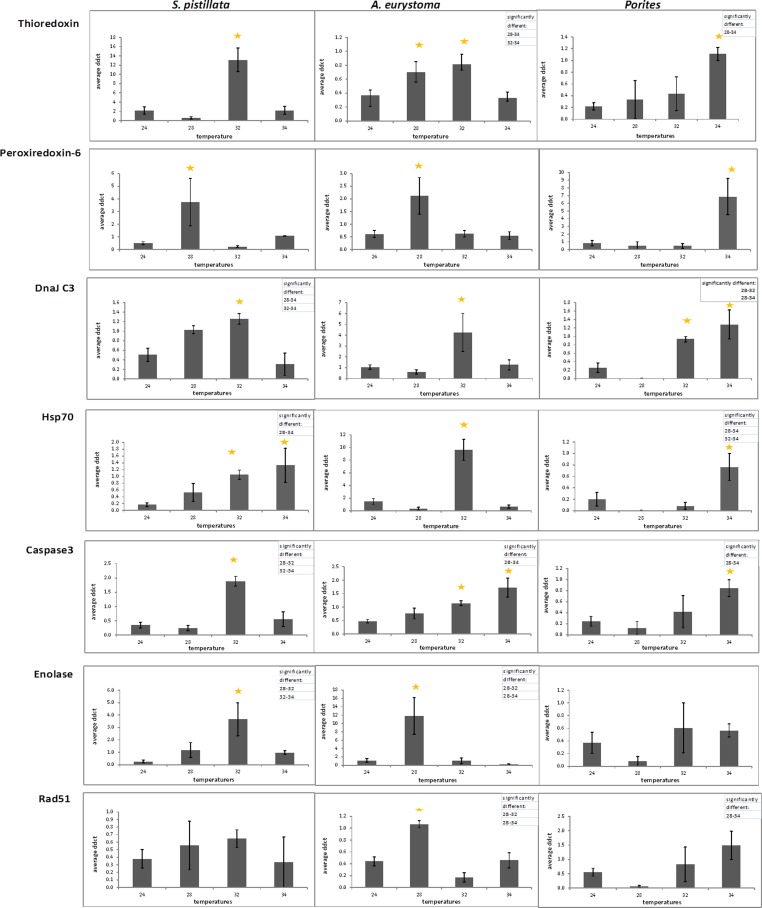
Gene expression following treatment of 28 °C, 32 °C, 34 °C and in 24 °C control treatment.Gene expression (represented as average ΔΔCT) of thioredoxin, peroxiredoxin-6, Dnaj C3, Hsp70, caspase 3, enolase and Rad51 in S. pistillata , A. eurystoma and Porites following treatment of 28 °C, 32 °C, 34 °C and in 24 °C control treatment. Results were subjected to One-way ANOVA followed by post-hoc LSD/bonferroni multiple-comparisons test (p < 0.05). Treatments significantly different from control were considered as up-regulated and indicate with an asterisk. The table in the right hand upper corner contains additional significantly different treatments.